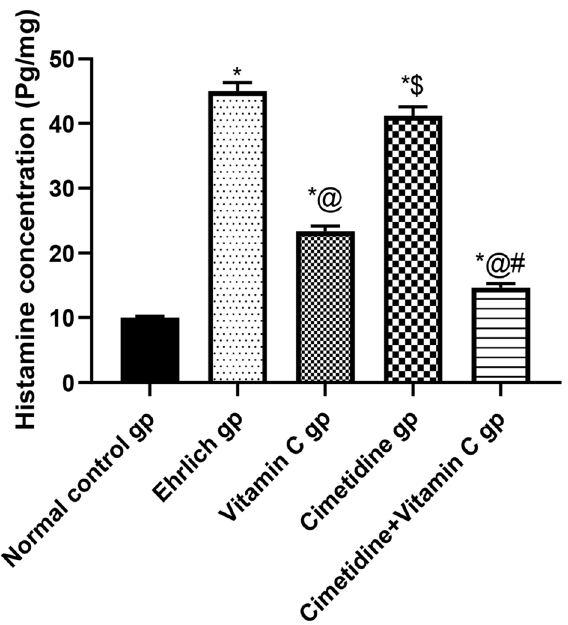
Figure 8. The changes in the tissue level of histamine following treatment with cimetidine at a dose of 200 mg/ kg/day, vitamin C at a dose of 4 g/kg/day, and their combination for 15 days after Ehrlich induction of breast cancer in mice. Data are presented as mean ± SD.* is significantly different from the normal control group, P < 0.05. @ is significantly different from Ehrlich untreated group, P < 0.05. $ Significantly different from vitamin C- treated group, P < 0.05. # is significantly different from cimetidine-treated group, P <